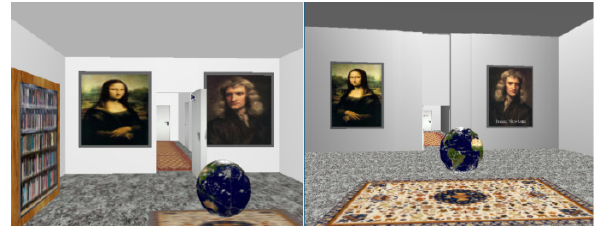
Figure 7. 3D environment developed using OpenGL ES (left) and X3D (right).